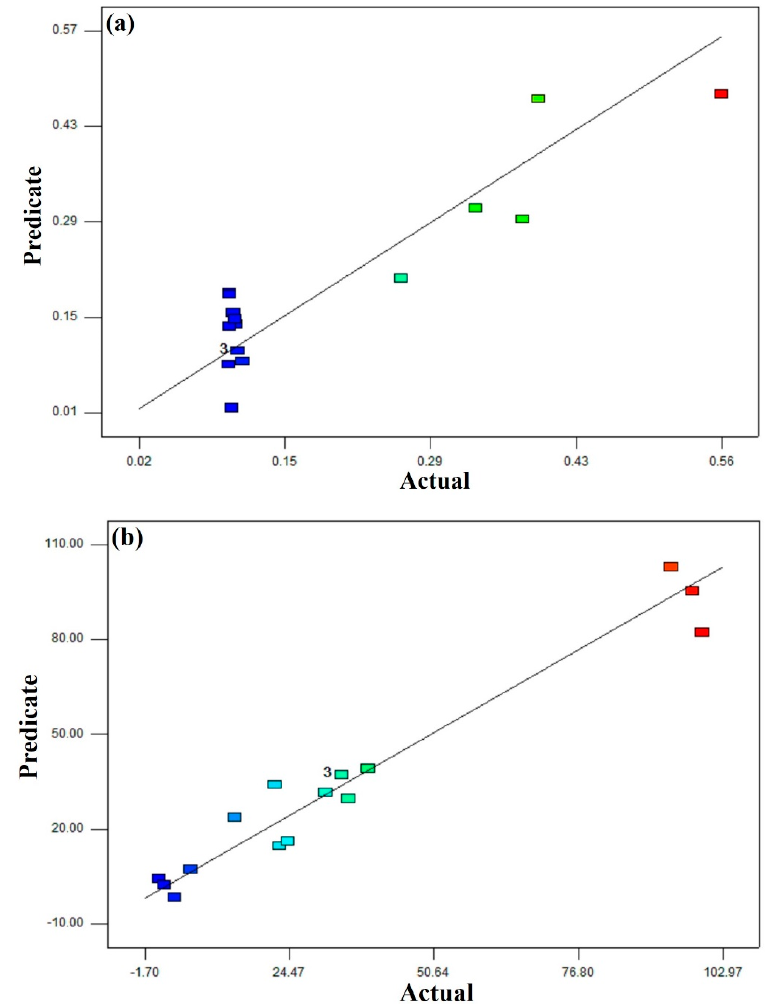
Figure 8. Parity plot of actual and predicate values of ( a ) removal (%) and ( b ) capacity (mg/g).